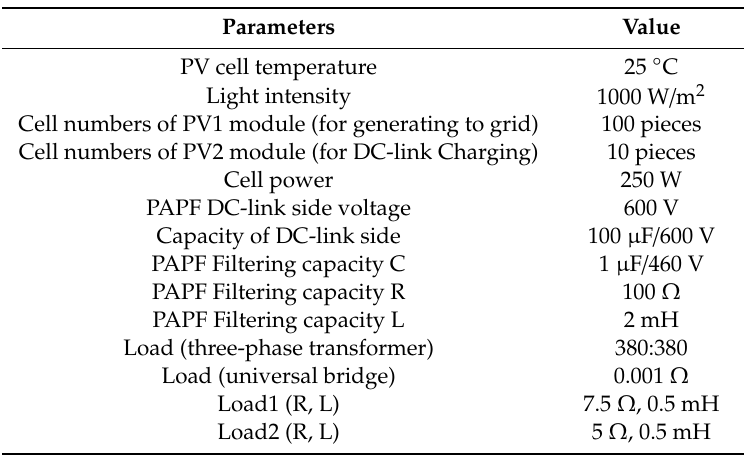
Table 1. The parameters of the PAPF in the UPQC.